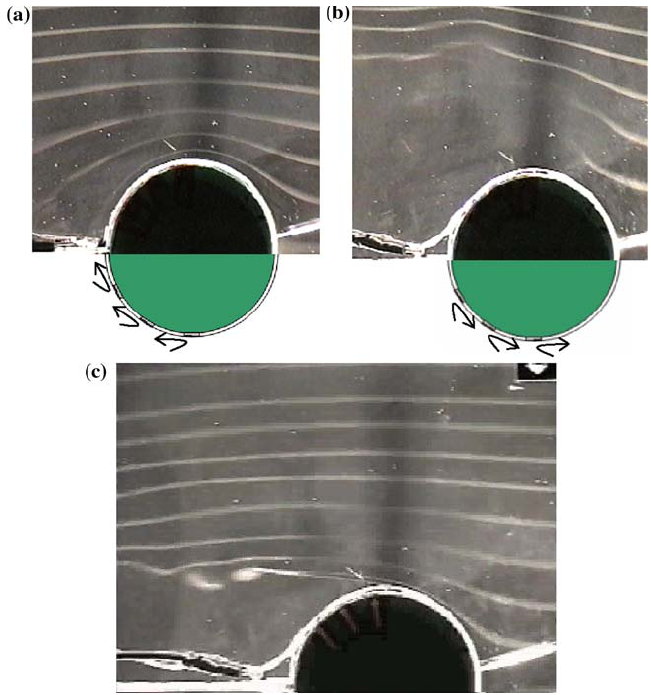
Figure 7. Smoke visualization of the instantaneous flow around a circular cylinder with and without DBD plasma actuators at Re D = 1.8 × 10 4 : ( a ) Forward electrode configuration, ( b ) backward electrode PIV images of Fig. 10, which covers the range down- configuration, and ( c ) uncontrolled flow. The free stream is from right to left and the schematics on the stream of the cylinder from x/D = 2 to x/D = 3, for the same flow conditions of Fig. 9. Figure 10a is the case lower half of the pictures show the flow induced by the DBD actuators. Reprinted by permission from with the plasma off, whereas Fig. 10b is the case with the the work by the authors of [101], c (cid:13) Springer-Verlag, 2006.